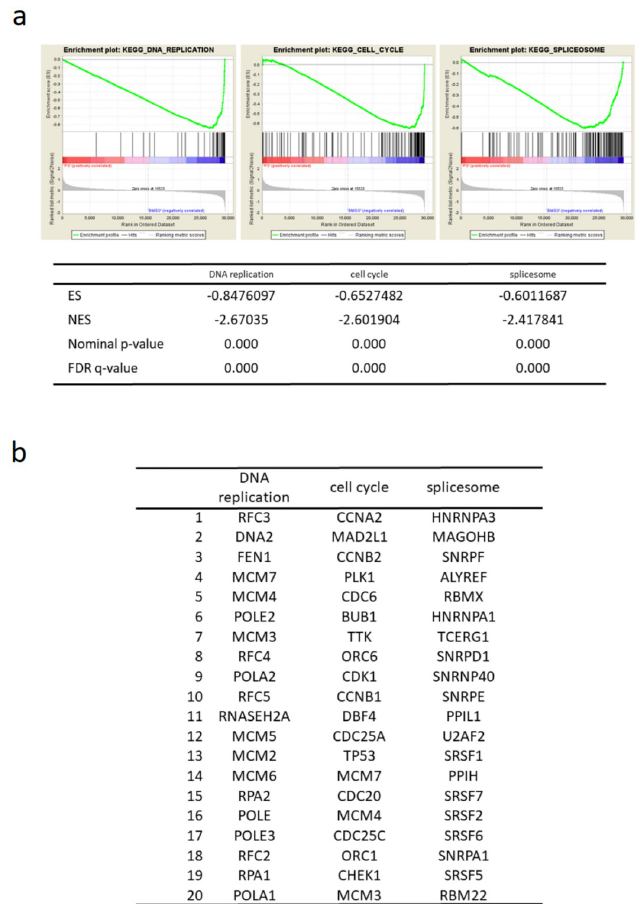
Fig 4. The gene enrichment analysis (GSEA) revealed the down-regulated gene sets: “DNA replication”, “cell cycle”, and “splicesome” in PS-treated KGN cells. a) PS (100 nM)-treated or untreated KGN cells were harvested at 24 hr. Gene expression profiling of KGN cells was examined in triplicate experiments and obtained data were used for GSEA by handling the GSEA software and the Molecular Signatures Database according to the references. The gene set “DNA replication”, “cell cycle”, and “splicesome” was strongly down-regulated by PS treatment and several statistical values are also presented. ES: enrichment score, NES: normalized enrichment score. b) The top 20 of most significant differentially expressed genes detected by GSEA analysis was